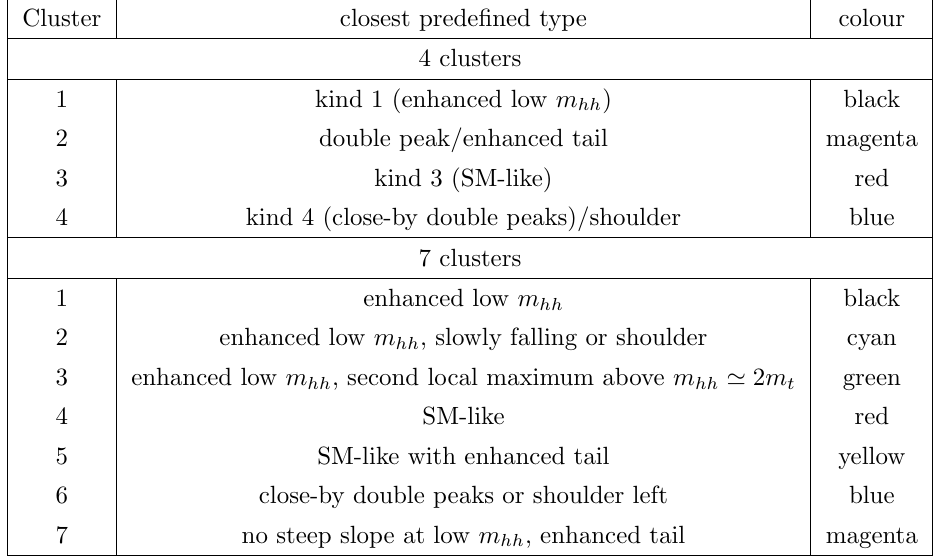
Table 1 . Clusters and shape types with corresponding colour codes for the classi(cid:12)cation into four and seven